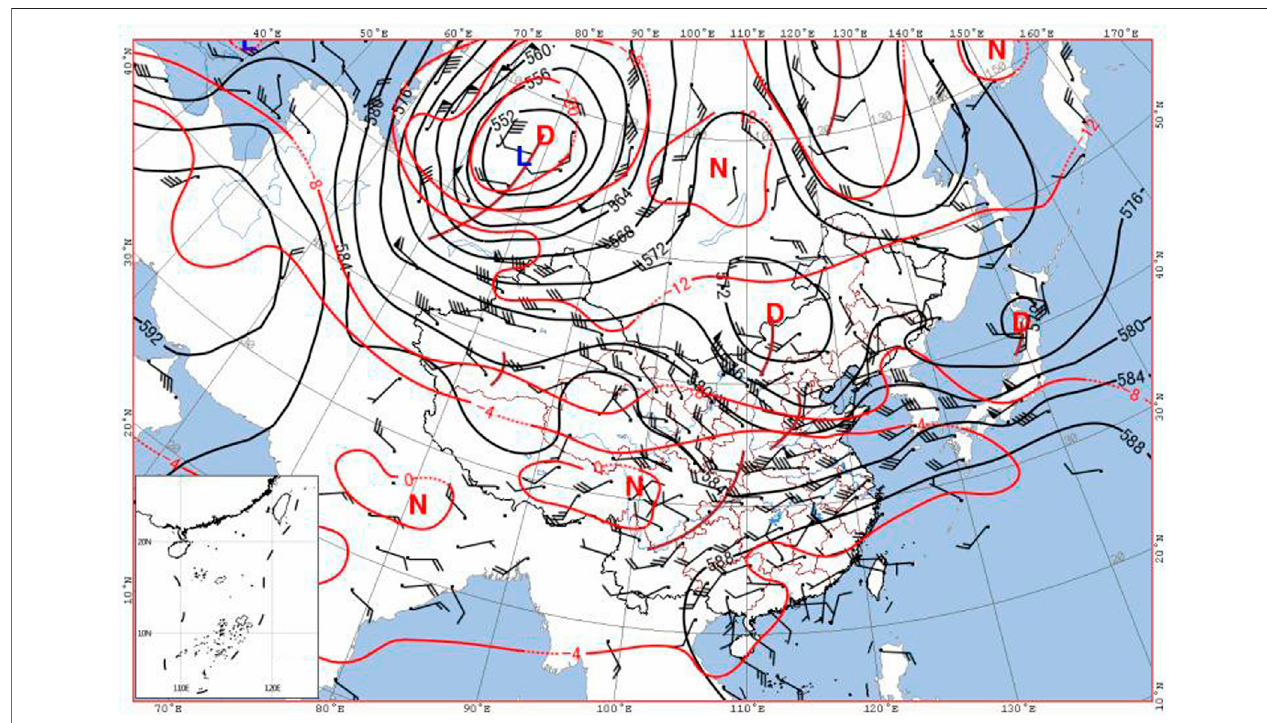
FIGURE4| Wind fi eld,height fi eld(blackisolines)andtemperature fi eld(redisolines)at500 hPaat08:00onJuly10,2010.(G.D,NandLarehighpressurecenter, low pressure center, warm center and cold center in turn)